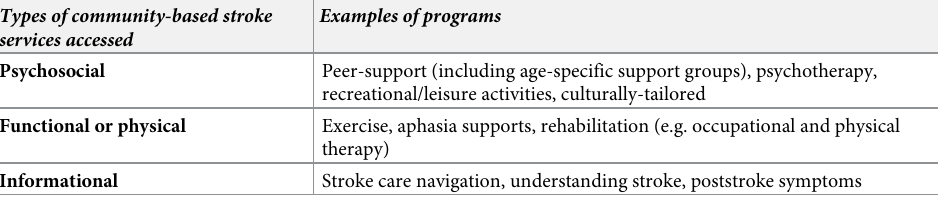
Table 3. Examples of community-based stroke services accessed by participants.